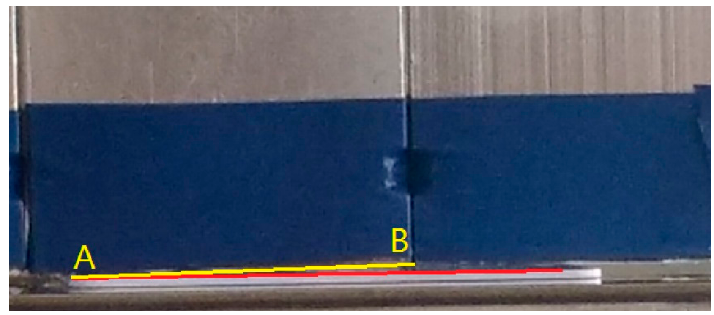
Figure 10. Schematic diagram of probe installation error.